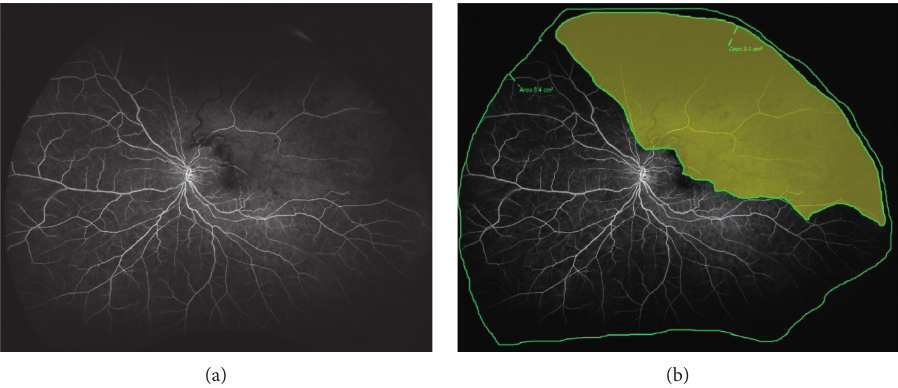
Figure 1: UWFFA images of a left BRVO eye. (a) The original UWFFA image. (b) The yellow mask showed the NPA. The outer circle outlined the total retinal area (8.4cm 2 ) and the inner circle outlined the NPA (3.4cm 2 ).